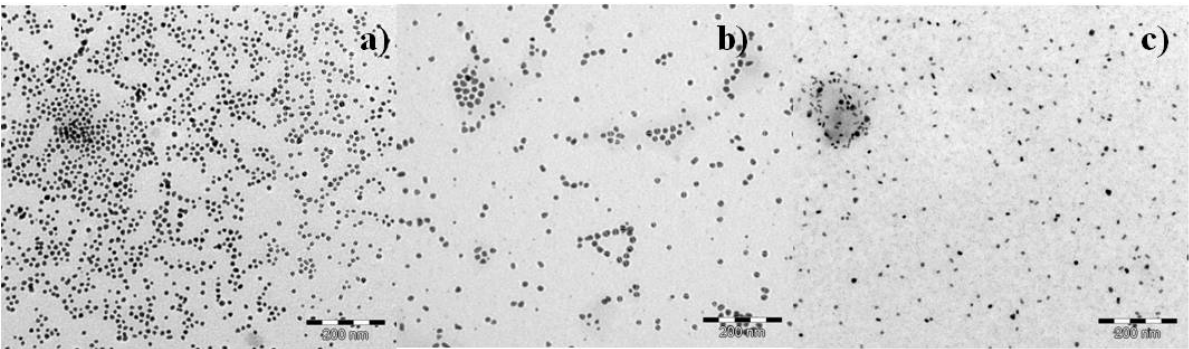
Figure 4. Co nanoparticles obtained with P41Boba polymer after 48 h at 120 °C for ( a ) Boba:Co = 1 (0.8 wt% Co) ( b ) Boba:Co = 0.65 (1.25 wt% Co) ( c ) Boba:Co = 0.16 (4 wt% Co). Scale bars: 200